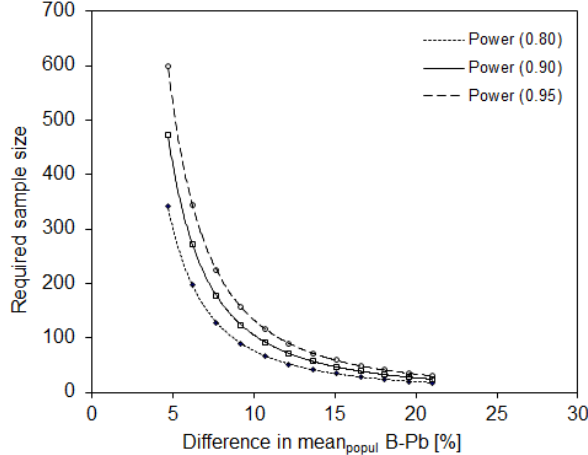
Figure 4. The sample size required to reveal a significant difference in mean blood Pb between two population groups, assuming that all analyses are performed in one laboratory. Statistical power = 0.80, 0.90 and 0.95; α = 0.05; one-sided.